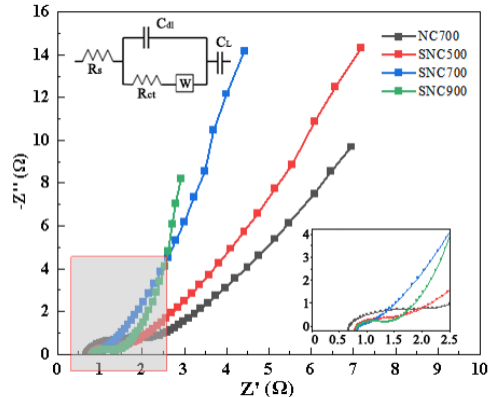
Figure 12. Electrochemical impedance spectra of SNC and NC at different carbonization temperatures (The equivalent circuit diagram of this electrode is shown in the upper left corner of the figure).